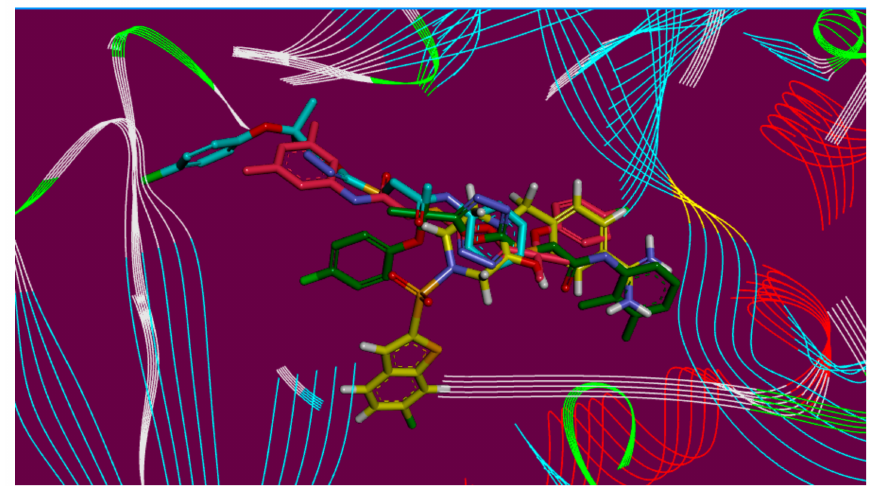
Figure 4. Overlap of bound conformations of RPR200095 (yellow) with compounds 3a (blue), 3i (pink), and 3e